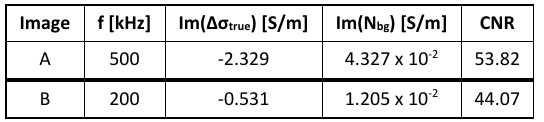
Table 8: Some quantitative data on the true images Im(Δ σ true ) in figure (9).